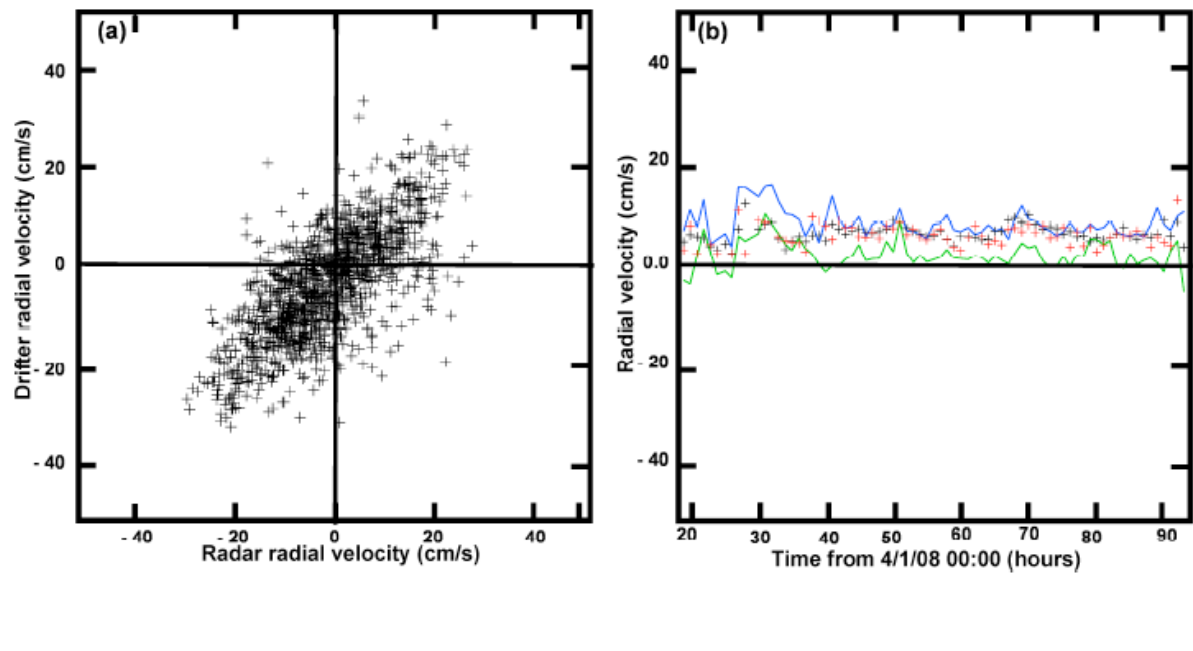
Figure 11. (a) Scatter plot of radial velocity data points: Drifter vs . radar; (b) Comparison statistics averaged over the map, plotted vs. time: Blue—standard deviation between radar and drifter radial velocities. Green—bias. Red—spatial standard deviation in COMM radials Black—temporal standard deviation in COMM